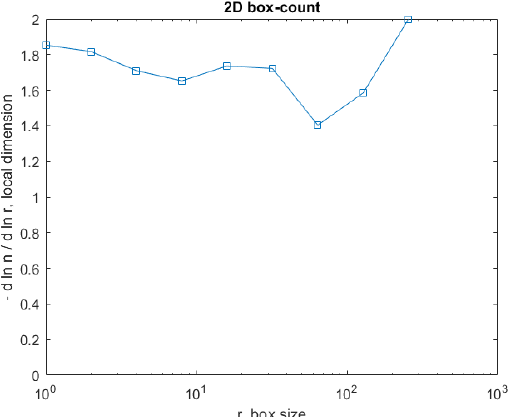
Figure 30. Two-dimensional box-count algorithm for the local fractal dimension.